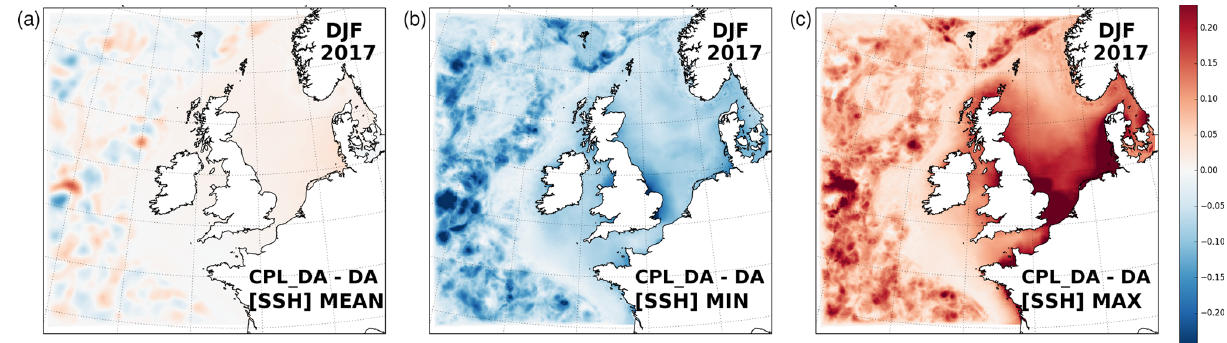
Figure 14. Difference in (a) mean SSH (CPL_DA − DA) due to wave coupling between experiments with data assimilation, calculated as a 3-month seasonal mean for winter 2017, and (b) minimum instantaneous difference, (c) maximum instantaneous difference in SSH between simulations at each grid point during the 3-month